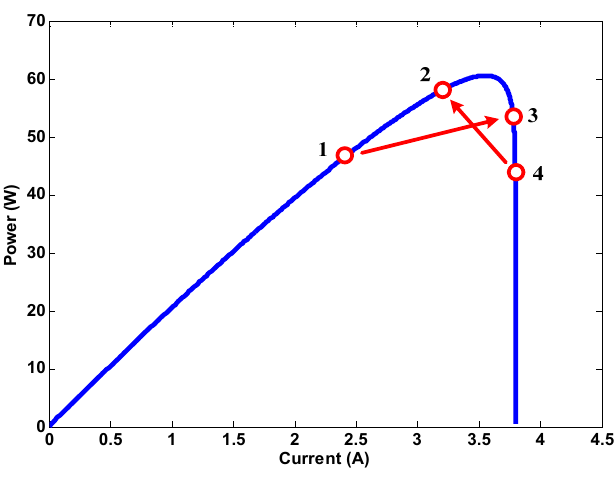
Figure 19. Example of rule conflictions for